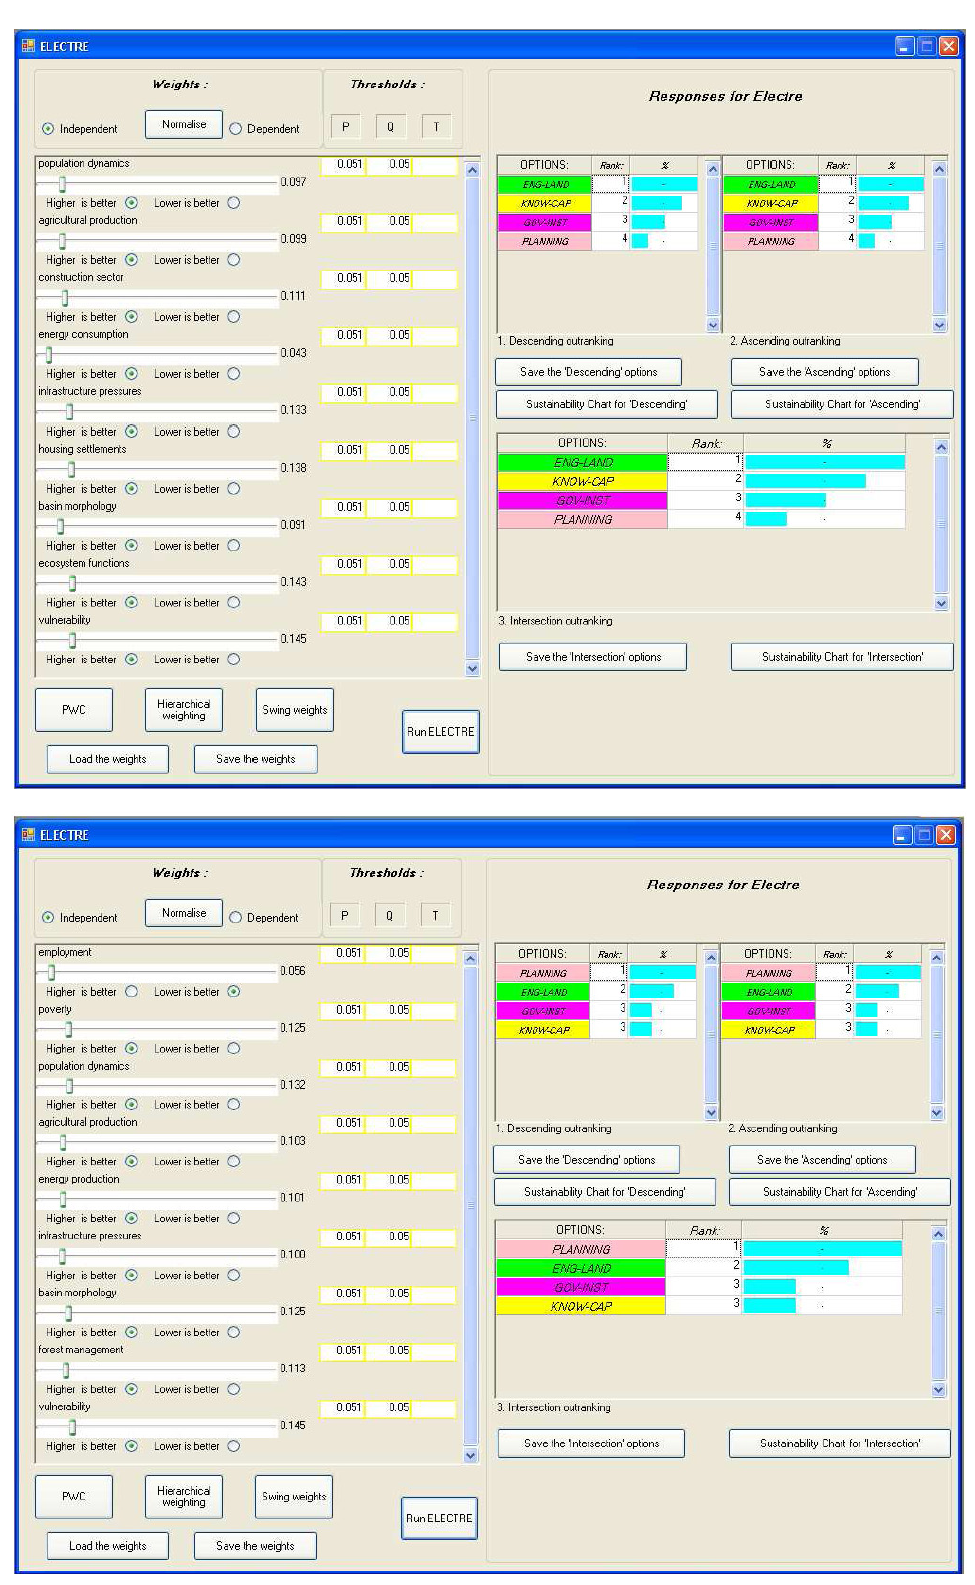
Figure 2. UDRB (top) and UBRB (bottom): ELECTRE III Analysis of alternative Responses. On the left side we can see the applied criteria weights and thresholds, while on the right side the ELECTRE III window appears with the final ranking (screenshot of the mDSS